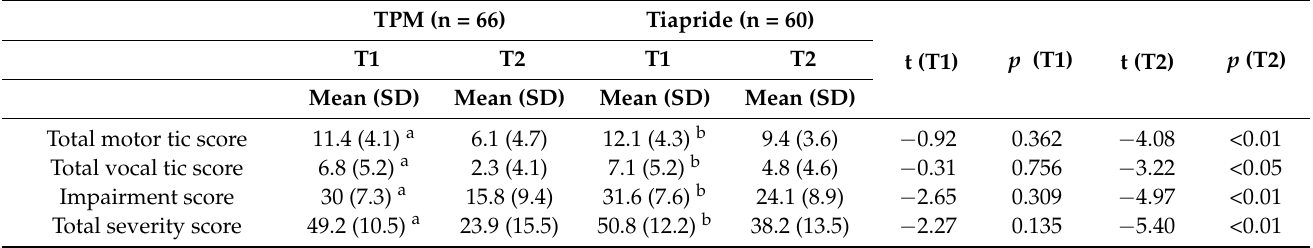
Table 2. Comparison of the YGTSS scores between TPM group and tiapride group.